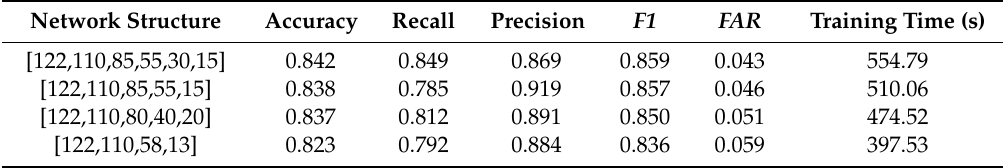
Table 3. Experimental performance of di ff erent network